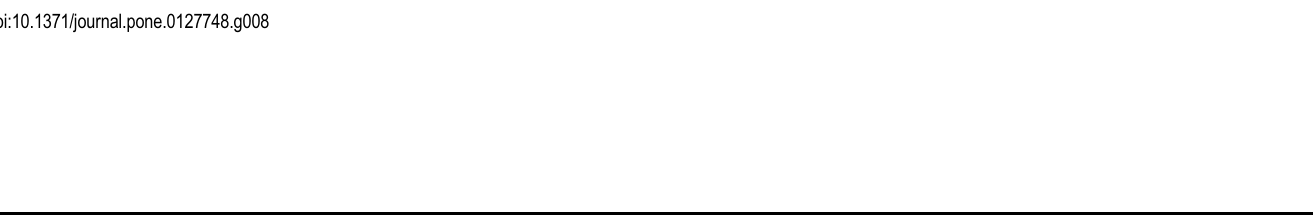
Fig 8. Results of the different methods applied to the DRIVE dataset: (a) original images; and (b) manually segmented images. (c-d) Results of methods reported in reference [9] and [18]. (e) Results of the proposed